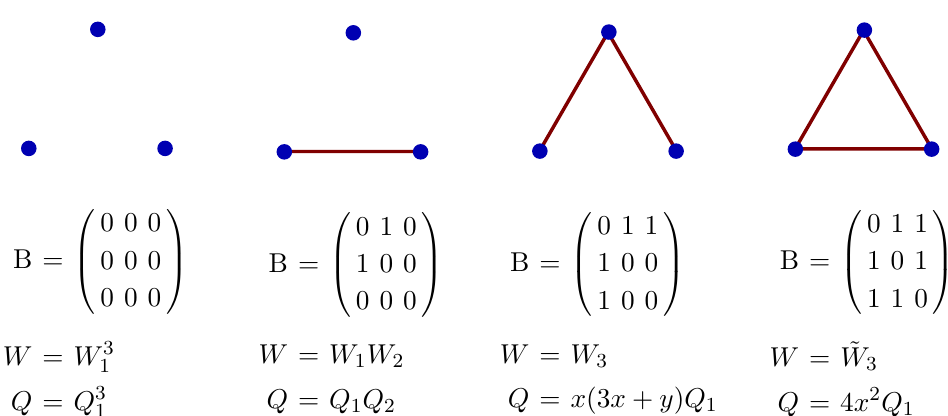
Figure 4 . Graphs, their adjacency matrices, refined and interlace polynomials, associated with the four T-dual classes of n = 3 codes. The polynomials W 1 , W 2 , W 3 are defined in (3.36), and ˜ W 3 + 3 xy 2 + 4 z 3 = − W 3 . 3 ≡ x 3 + 3 W 1 W 2 + W 1 For n = 1 and n = 2 , all polynomials W ( x, y, z ) invariant under (3.32) and y → − y